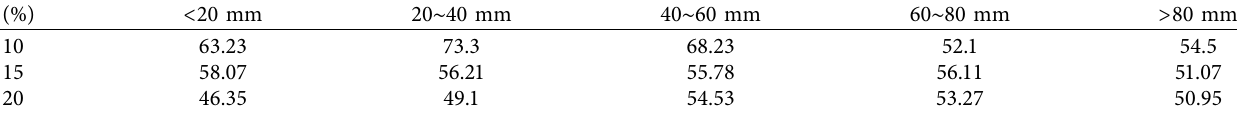
Table 1: The influence of modified asphalt content on the ductility of petroleum